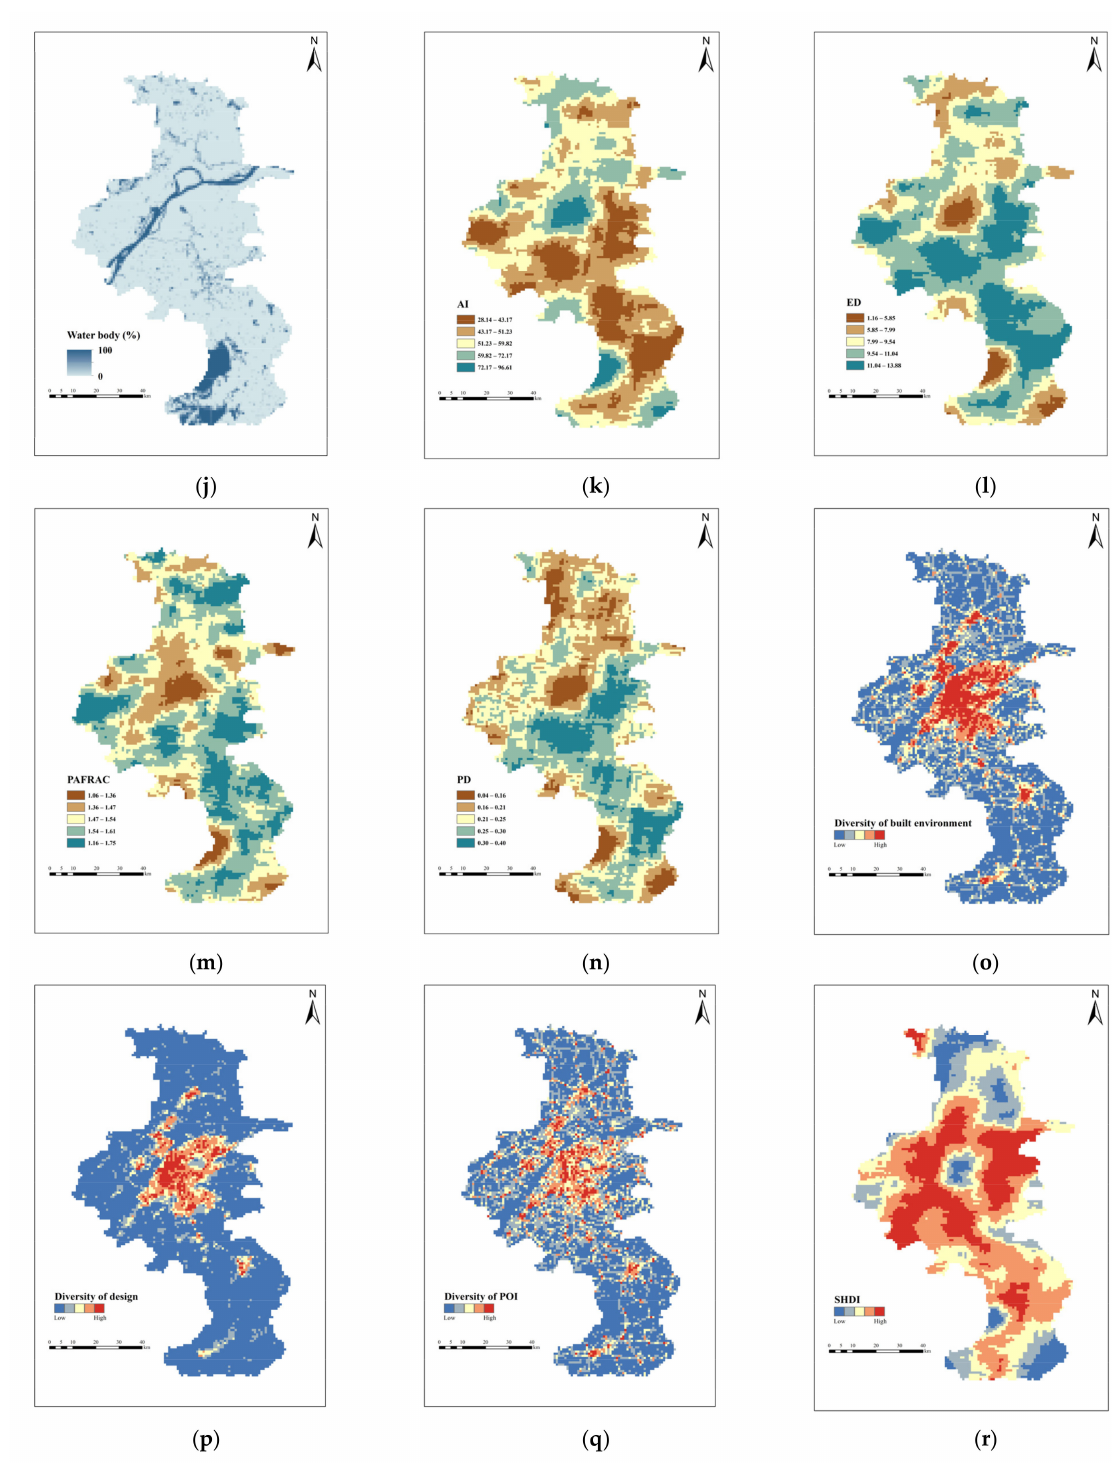
Figure 3. Spatial patterns of the built environment. ( a ) Building density; ( b ) building height; ( c ) stan- dard deviation of building height; ( d ) NDVI; ( e ) road length; ( f ) road crossing; ( g ) POI of seven types; ( h ) proportion of construction land; ( i ) proportion of forestland; ( j ) proportion of water body; ( k ) aggregation index; ( l ) edge density; ( m ) perimeter-area fractal dimension; ( n ) patch density; ( o ) diversity of the built environment; ( p ) diversity of design; ( q ) diversity of design; ( q ) diversity of POI; ( r ) diversity of land